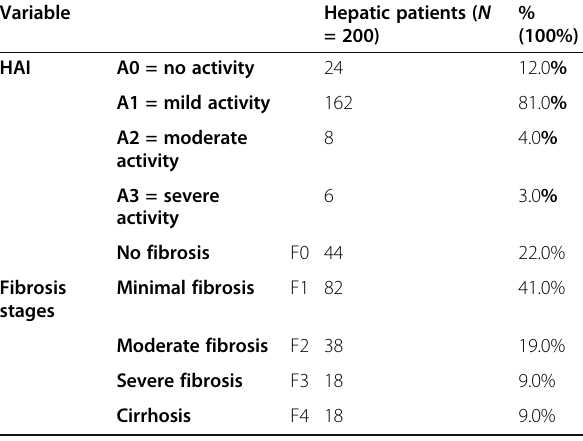
Table 2 Histopathological evaluation of the liver biopsy specimens among the study group according to METAVIR scoring system